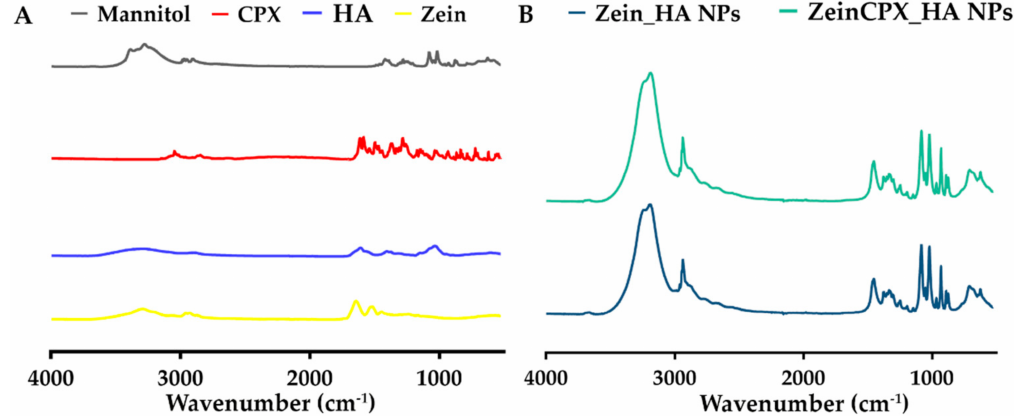
Figure 2. FTIR spectra of the NPs and raw materials: ( A ) spectra of the raw materials (zein, HA, CPX, and mannitol) used for the production and lyophilization of the NPs; ( B ) spectra of the Zein_HA NPs and ZeinCPX_HA NPs.